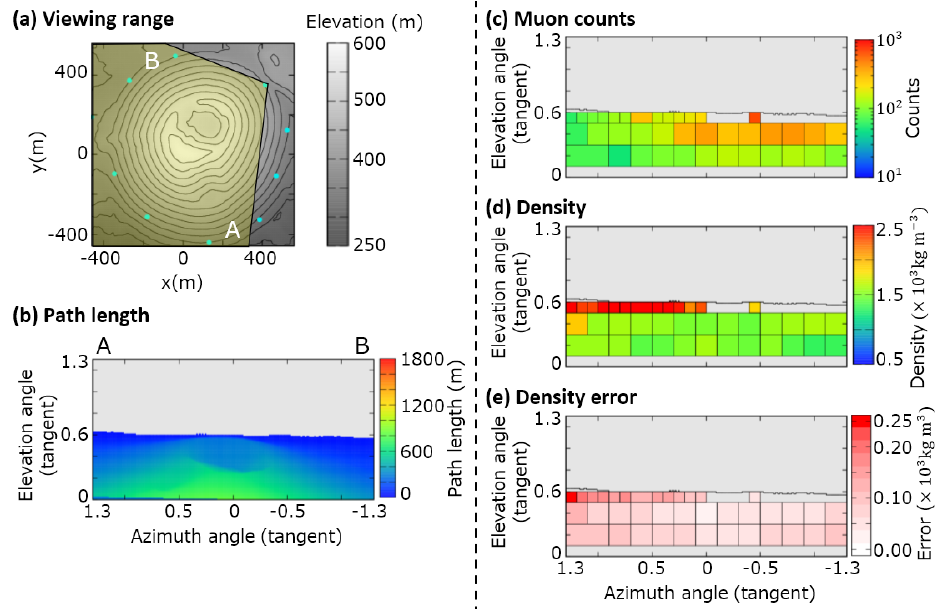
Figure B9. Observation site NE. (a) Map, topography, and viewing range; (b) path length of the volcanic cone; (c) muon counts N obs (d) density ρ i . The maximum value of the color bar indicates a density of > 2 . 5 × 10 3 kgm − 3 and the minimum value is < 0 . 5 × 10 3 kgm − 3 .